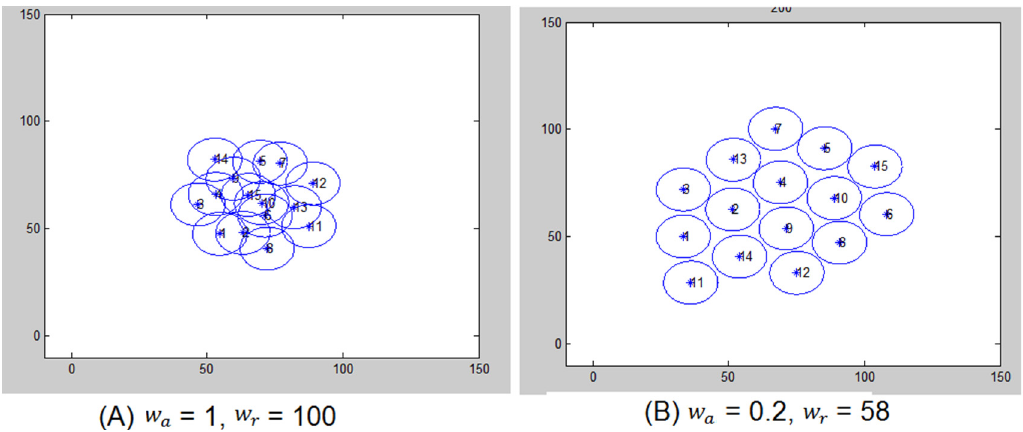
Figure 2. The effect on small number of robots N = 15.